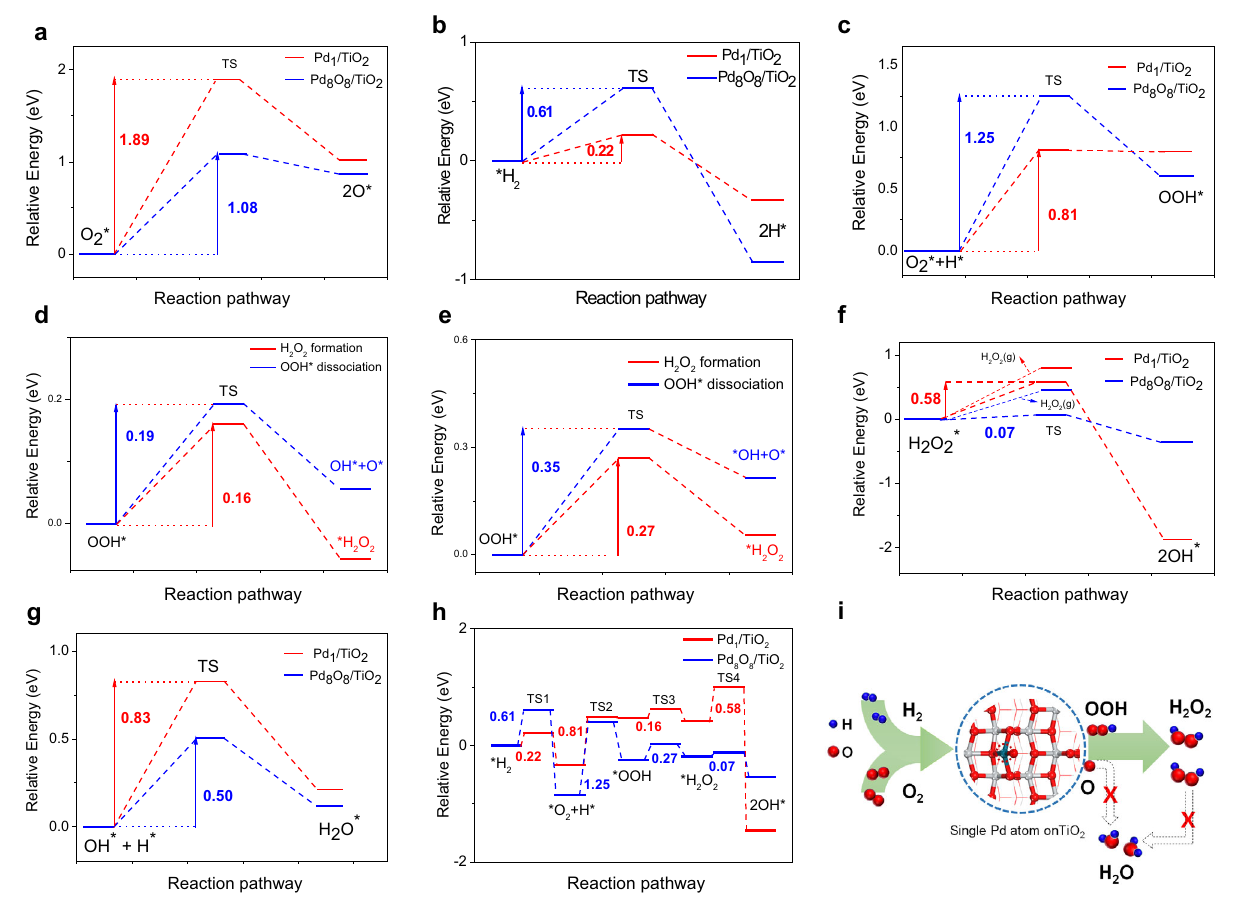
Fig. 5 | DFT calculations. a The reaction energy barriers of adsorbed *O 2 dis- sociationstepsonPd 1 /TiO 2 andPd 8 O 8 /TiO 2 . b Energypro fi lesforH 2 dissociationon Pd 1 /TiO 2 and Pd 8 O 8 /TiO 2 . c The reaction energy barriers of adsorbed *O 2 hydro- genationstepsonPd 1 /TiO 2 andPd 8 O 8 /TiO 2 . d ThereactionenergybarriersofH 2 O 2 formation and OOH dissociation on Pd 1 /TiO 2 . e The reaction energy barriers of